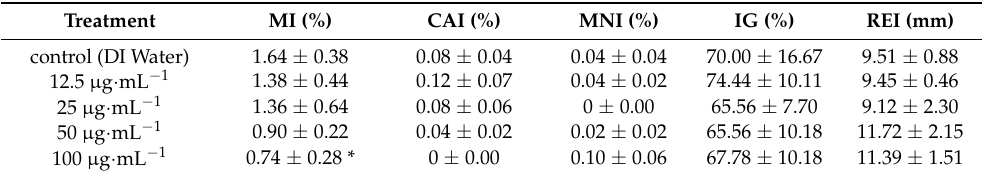
Table 2. Results of Allium cepa assay treated with solutions of CA-NPs. Data represent the mean ± standard error.